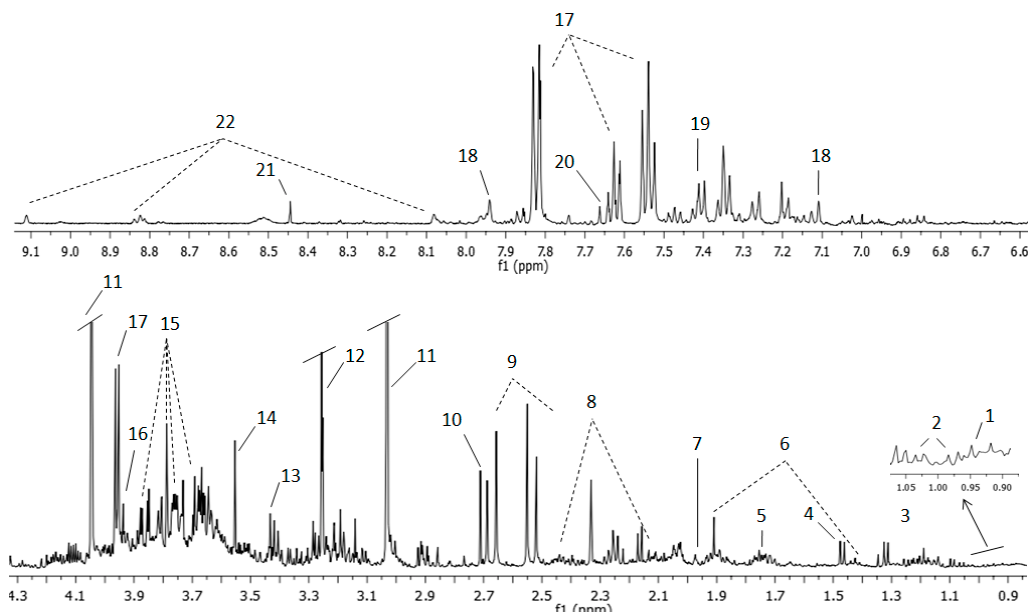
Figure 1. Representative 1 H NMR spectrum and assignment of a urine sample from an NMIBC patient. Aromatic (top) and aliphatic region (bottom) are displayed. The spectral regions of water and urea have been removed from the figure. The intensity of the aromatic region is increased to show the resonances in this area, usually less intense than those observed in the aliphatic region. Peaks for the most intense resonances in the aliphatic region are shown truncated (11, 12, and 17) in order to improve the visualization of the other signals with lower intensity in this same area. Assigned metabolites: